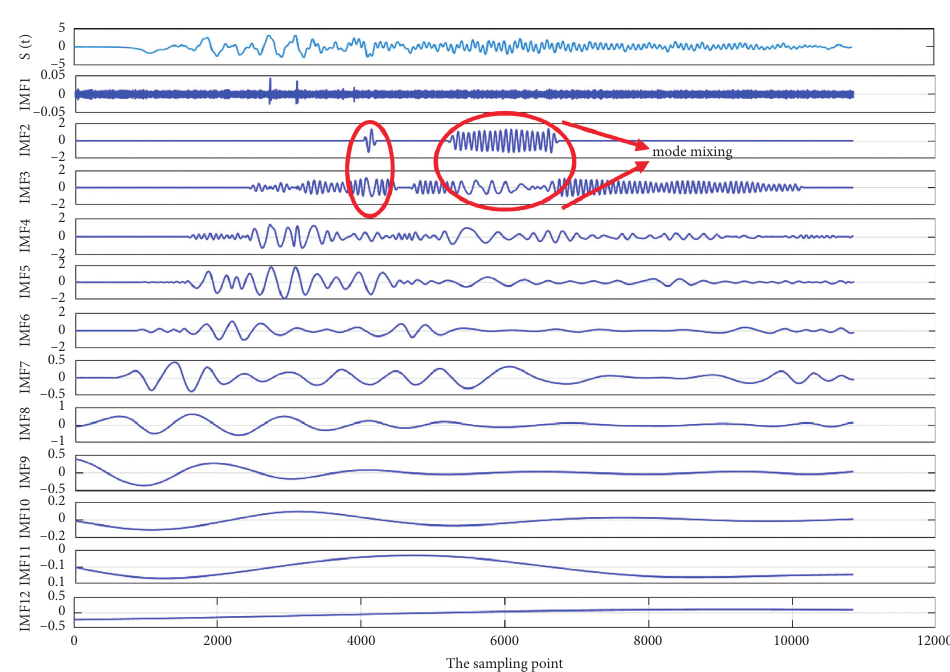
Figure 9: The decomposition results of dynamic signal by